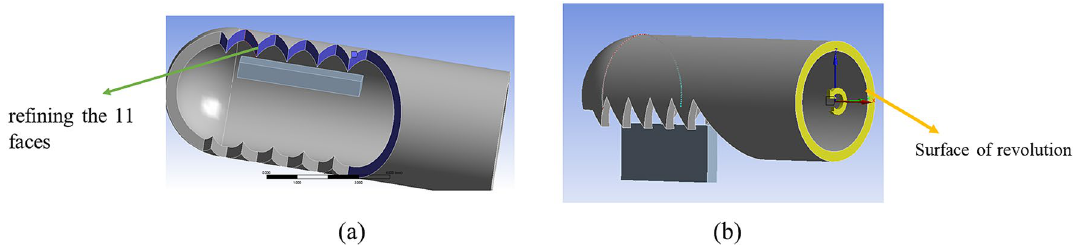
Figure 3. Mesh and boundary condition settings. ( a ) Mesh refinement. ( b ) Rotation face of shaver